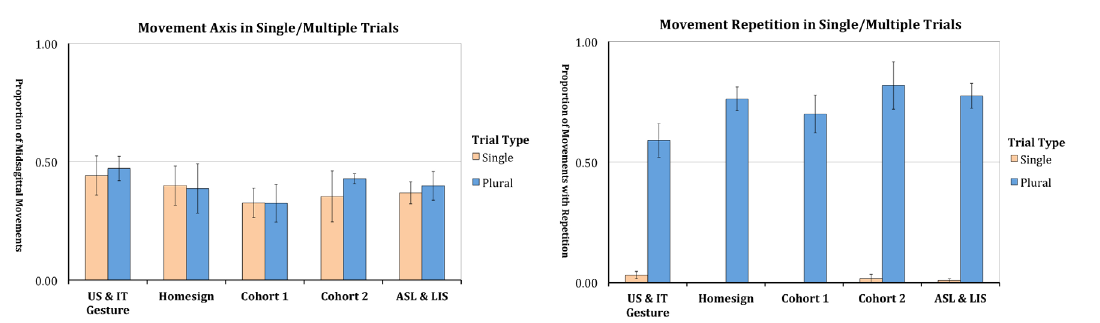
Fig. 6. The proportion of responses with Midsagittal Movements (left graph) and Movements with Repetition (right graph) in Single Trials (orange bars) and Plural Trials (blue bars) produced by Silent Gesturers, Homesigners, NSL Cohort 1 signers, NSL Cohort 2 signers, and ASL/LIS signers. Error bars indicate standard